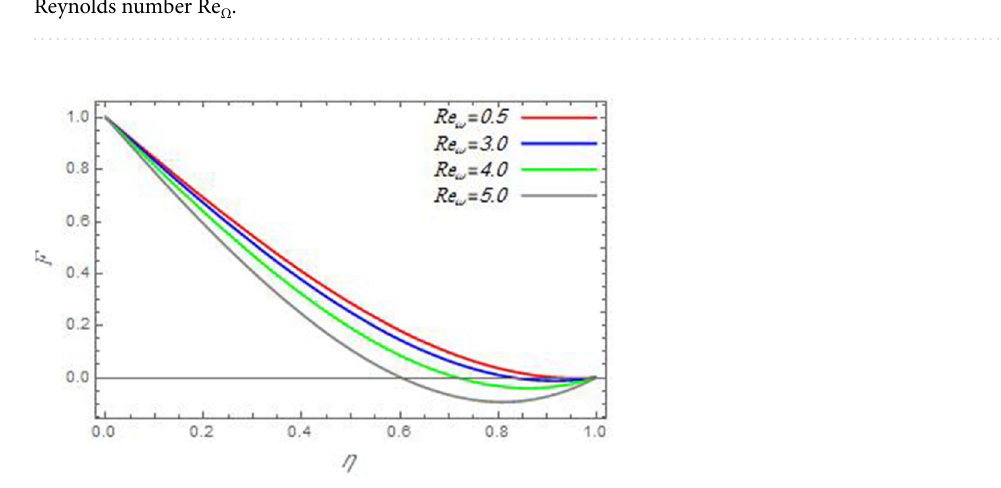
Figure 3. The radial velocity F versus the axial variable η in the case of stationary cone to depict the effect of the Reynolds number Re ω